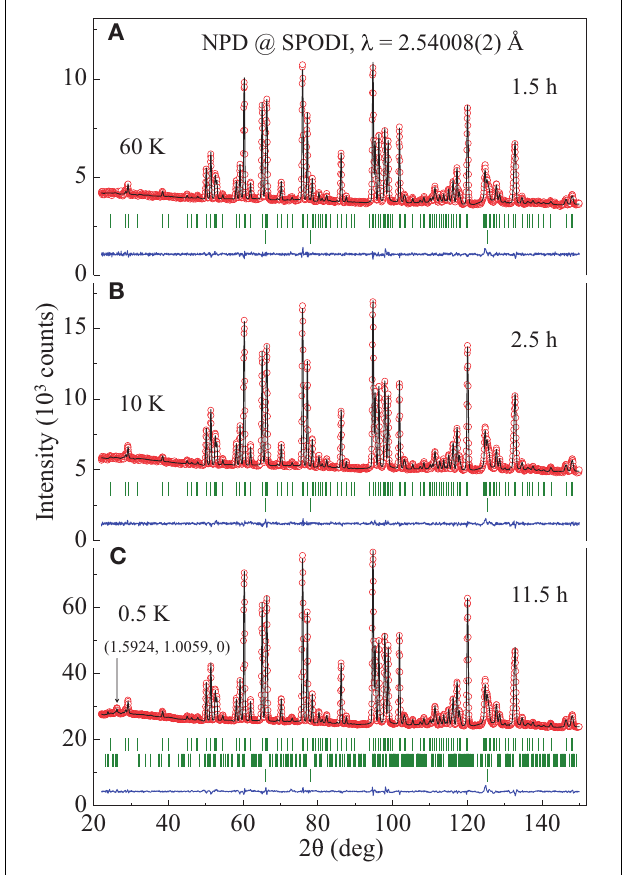
FIGURE 2 | Observed (circles) and calculated (solid lines) NPD patterns from the study using SPODI (FRM-II). (A) At 60K with counting time ∼ 1.5h. (B) At 10K with counting time ∼ 2.5h. (C) At 0.5K with counting time ∼ 11.5h. The vertical bars mark the positions of nuclear and magnetic Bragg reflections of SrTb 2 O 4 as well as the Al nuclear Bragg peaks (from sample environment), respectively. The lower curves represent the difference between observed and calculated patterns. No obvious diffuse magnetic scattering appears as observed in polycrystalline Sr RE 2 O 4 ( RE = Ho, Er, Dy) compounds in Ref.